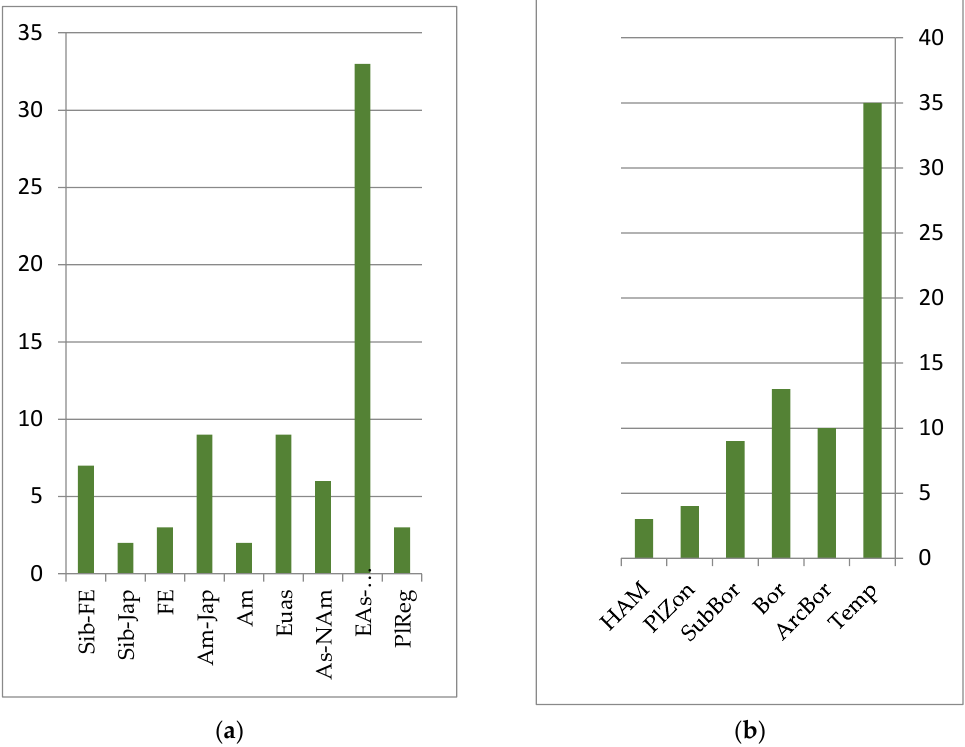
Figure 4. Number of species groups of the mire floristics complex: ( a ) longitudinal species groups: Siberian – Far Eastern (Sib-FE); Siberian – Japanese (Sib-Jap); Far Eastern (FE); Amurense – Japanese (Am-Jap); Amurense (Am); Eurasian (Eas); Asian – North American (EAs-Nam); Eurasian – North American (Eas-NAm); PlReg–pluriregional; ( b ) zonal species groups: temperate (Temp); arcto–boreal (ArcBor); boreal (Bor); sub-boreal (SubBor); plurizonal (PlZon); hypoarcto–montane